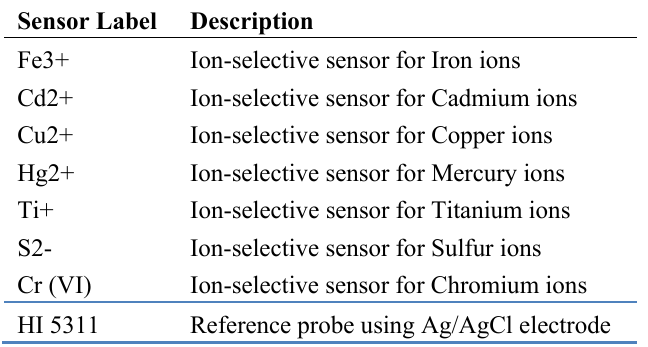
Table 3. Chalcogenide-based potentiometric electrodes used in the